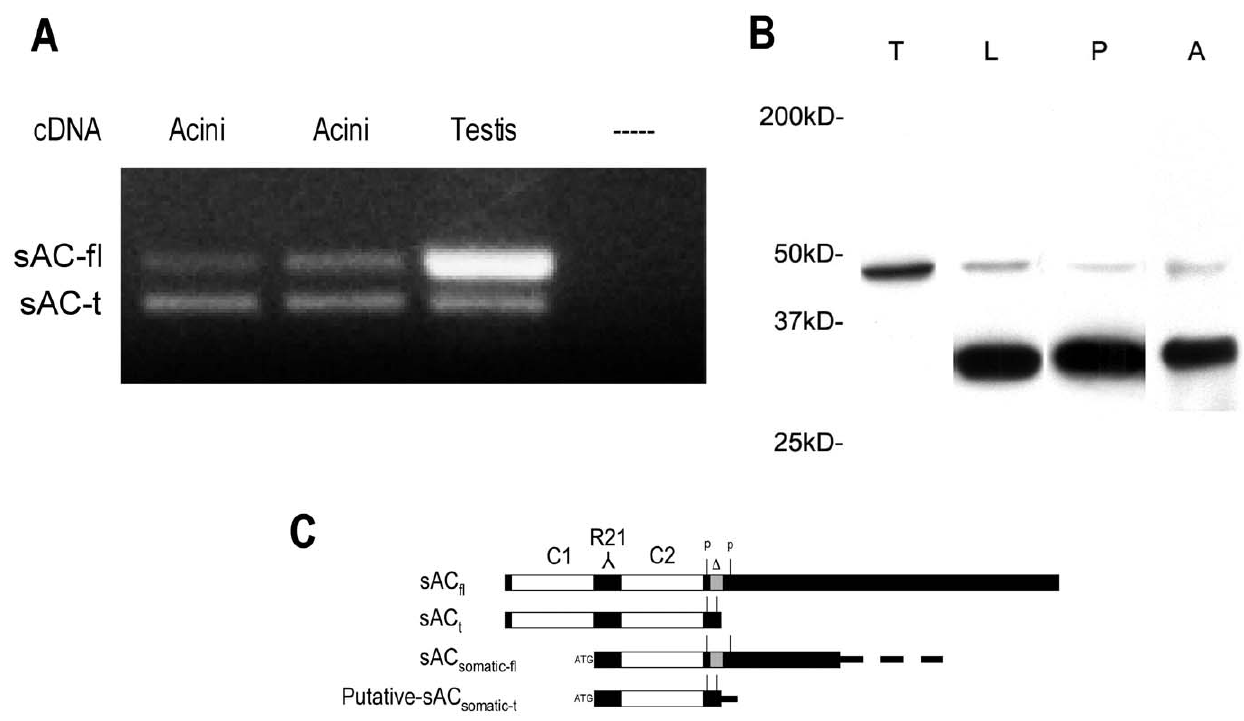
Figure 1. sAC is present in the pancreatic acinar cell. (A) RNA was isolated from pancreatic acini and the testis and PCR was performed using primers, which can distinguish full length (sAC-fl) from truncated sAC (sAC-t). Duplicates of cDNA from two different preparations of acini are shown (B) Immunoblot for sAC using sAC Ab (R21). Lanes: T:testis, L:liver and P:pancreas A:acini (50 m g protein/lane). (C) Diagram adapted from Wuttke et.al. [51] and Farrell et.al. [14] of sAC isoforms including full length (sACfl), truncated (sACt), somatic (sACsom) and a putative somatic truncation (putative sACsomtic-t). Also indicated are the PCR primer sites (P), the site of the 53 nt deletion( D ), the site of Ab R21 recognition (R21) and the two catalytic domains (C1 and